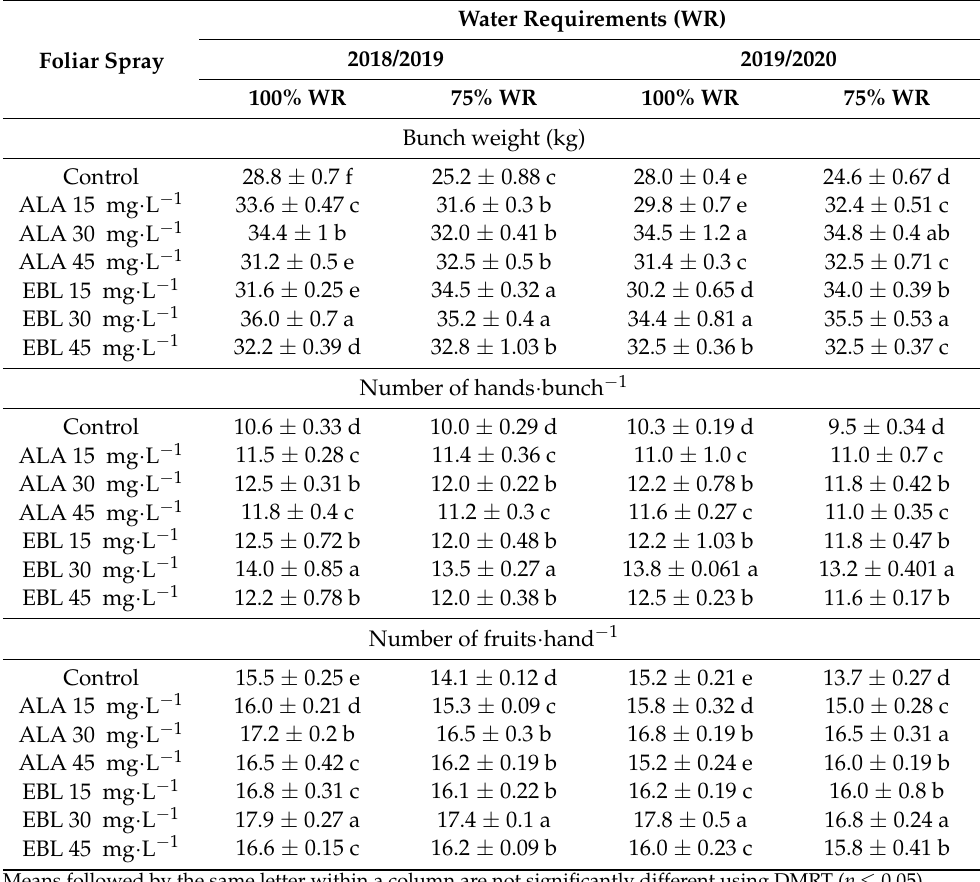
Table 3. Effect of foliar spray with ALA or EBL on the bunch weight, number of hands per bunch, and number of fruits per hand of drought-stressed “Williams” banana plants during the 2018/2019 and 2019/2020 seasons ( n =